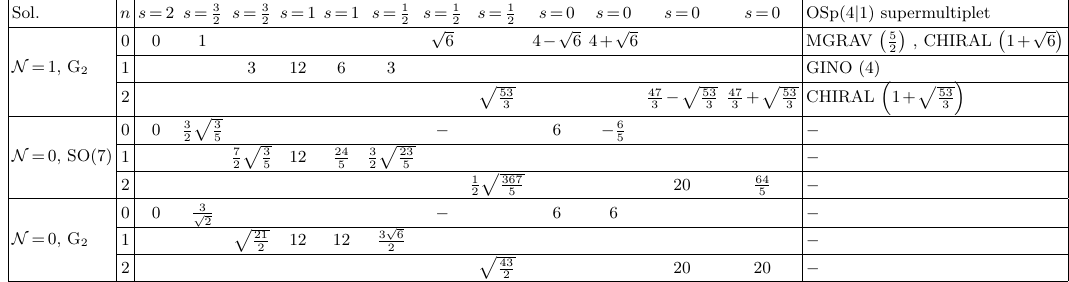
Table 22 . All G 2 -singlet states in the complete KK spectra of the AdS 4 solutions of type IIA indicated on the left-most column. The KK level n at which each state arises, its spin 0 ≤ s ≤ 2 , and the OSp (4 | 1) supermultiplet with the given dimension to which it belongs, if appropriate, are indicated. Each entry gives the mass (squared, m 2 L 2 , for the bosons and linear, | mL | , for the fermions) for each state in units of the AdS 4 radius L . These G 2 -singlet spectra are also the spectra of the D = 4 N = 2 theory of [72] around each of its three AdS